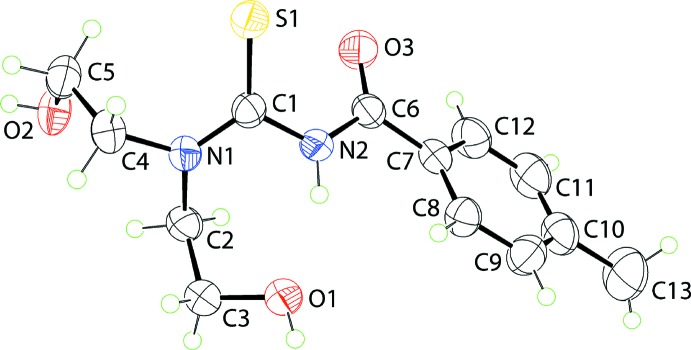
The mol­ecular structure of (I) showing the atom-labelling scheme and displacement ellipsoids at the 50% probability level.